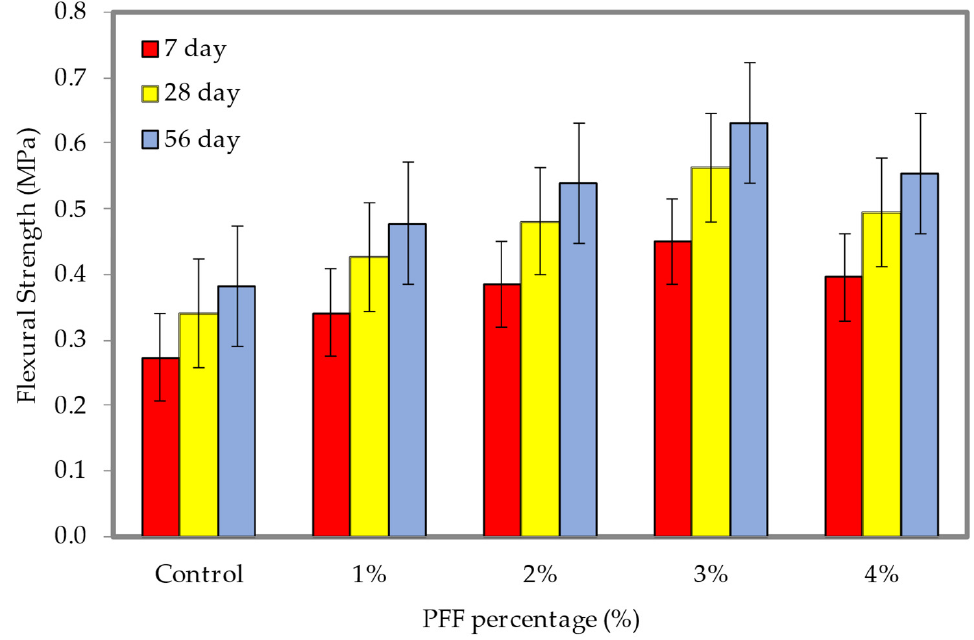
Figure 16. Flexural strength of foamed concrete of 600 kg/m 3 density with varying PFF percentages.